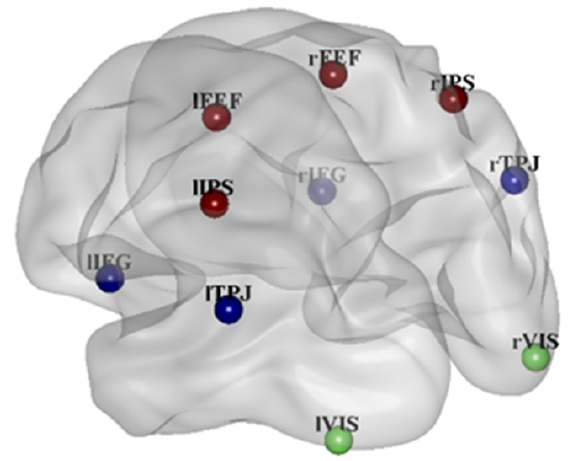
Figure 2. 3-D representation of ROIs. Ventral attention network is in blue (Inferior Frontal Gyrus (IFG), Temporal Parietal Junction (TPJ)). Dorsal Attention network is in red (Frontal Eye Field (FEF), Intraparietal sulcus (IPS)). The visual areas are in green.